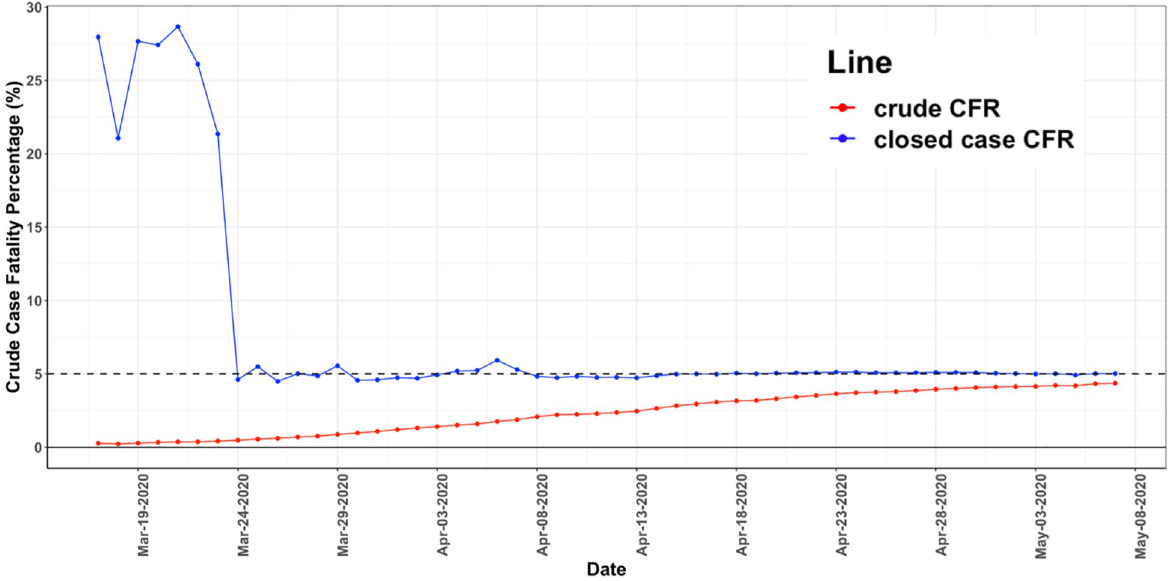
Fig 1. CFR crude (t) and CFR closedcase (t) versus time for Germany. The bottom curve (red) shows CFR crude (t) plotted versus day after outbreak. The top curve (blue) shows the same for CFR closedcase (t). CFR crude (t) increases over this period from a value of 0.12% to a value of 4.36%. It is seen that CFR closedcase (t) converges to the projected true of CFR crude earlier than the CFR crude (t) curve itself.